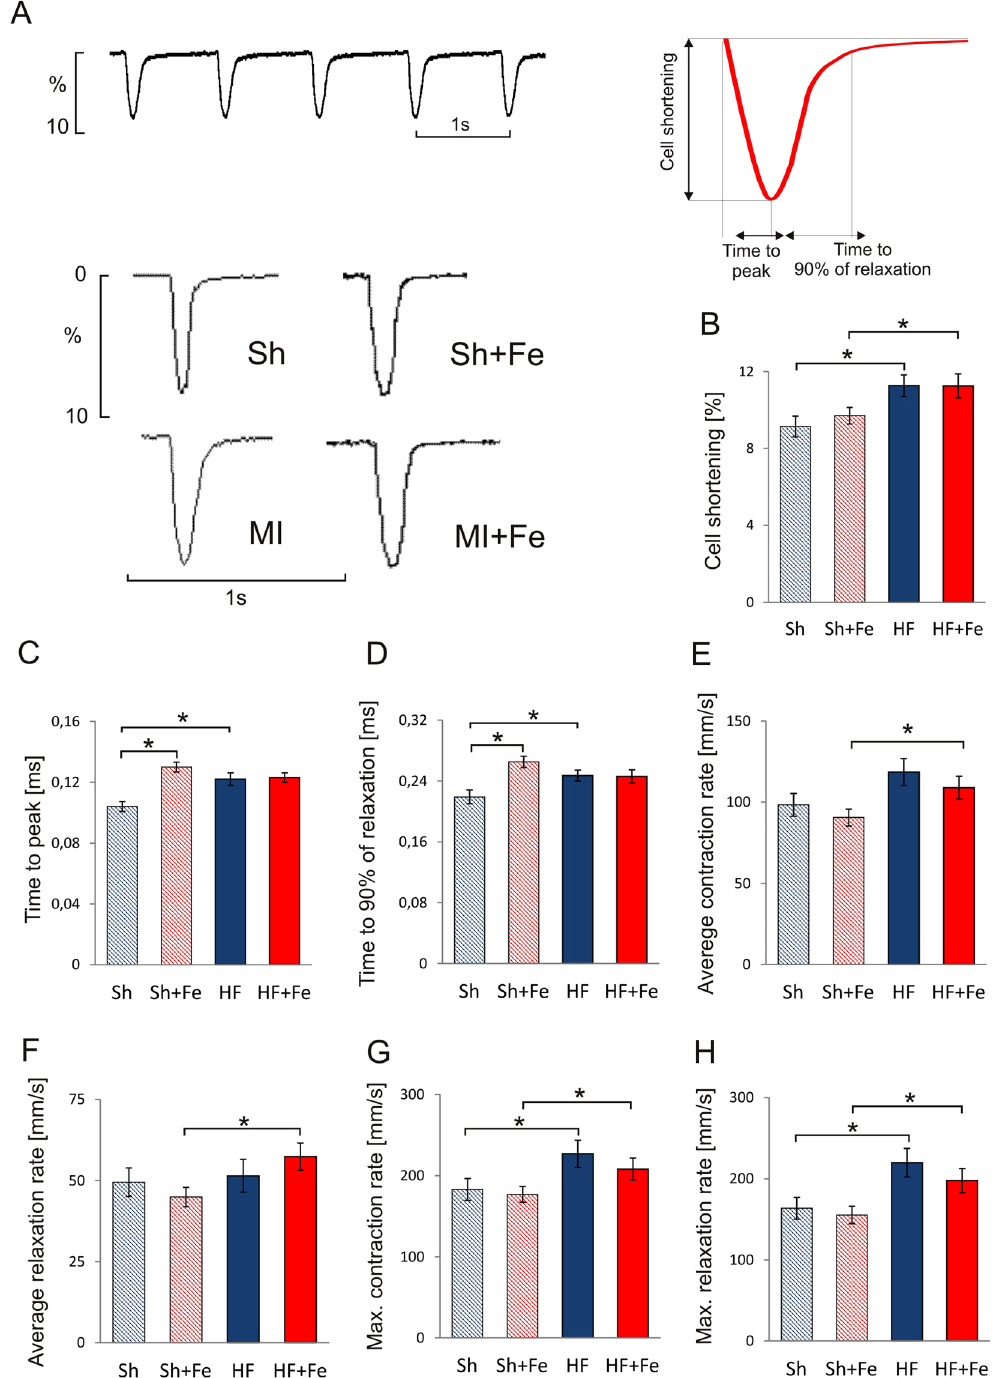
Figure 6. The effect of intravenous iron (Fe) supplementation on the contractile function of cardiomyocytes isolated from sham operated (Sh) and heart failure (HF) rats. ( A ) Representative recordings of cell shortening; ( B ) amplitude of cell shortening; ( C ) time to peak contraction; ( D ) time to 90% of relaxation; average contraction ( E ) and relaxation ( F ) rate; maximal contraction ( G ) and relaxation ( H ) rate. Data is represented as mean ± SEM, n = 10–23 cardiomyocytes/group from 5 hearts in each group, * p < 0.05, only statistically significant differences were